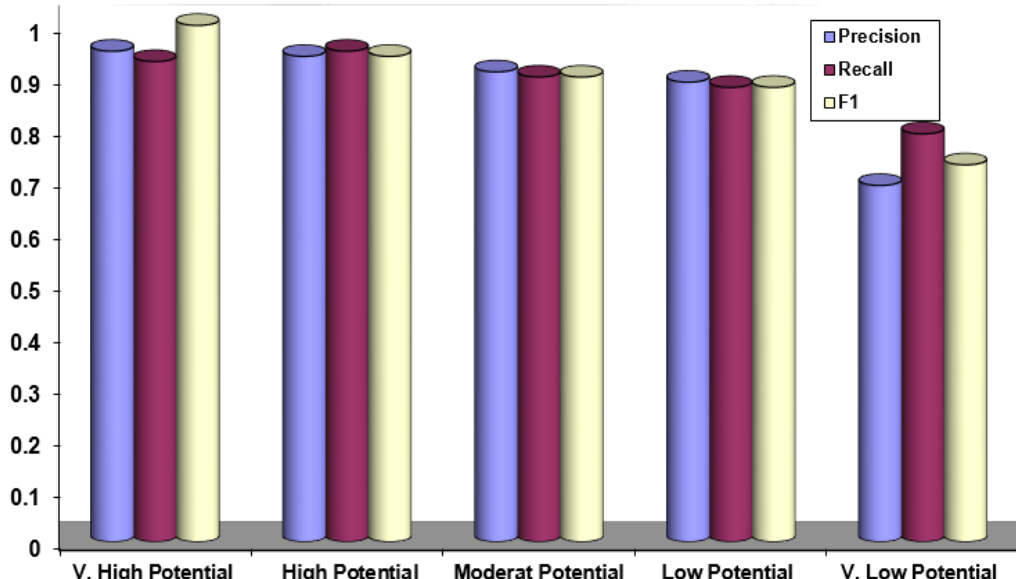
Figure 12. F1, precision, and recall scores for the groundwater potential zones mapped using the CART model.